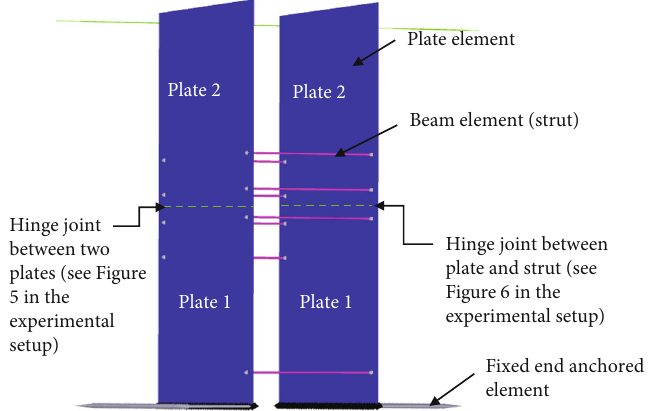
Figure 4: Structural simulation of the two assembled box shield (stacked upon each other) protection in PLAXIS-3D (number of structural elements: 1,050; MC soil model).